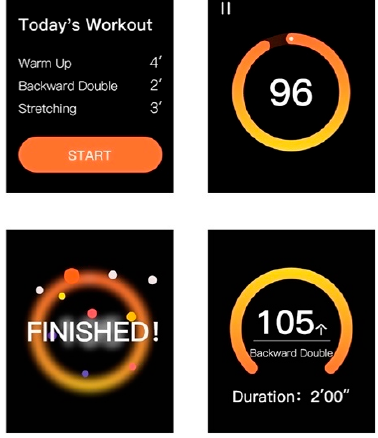
Figure 11. Exercise interface on smartwatch terminal.